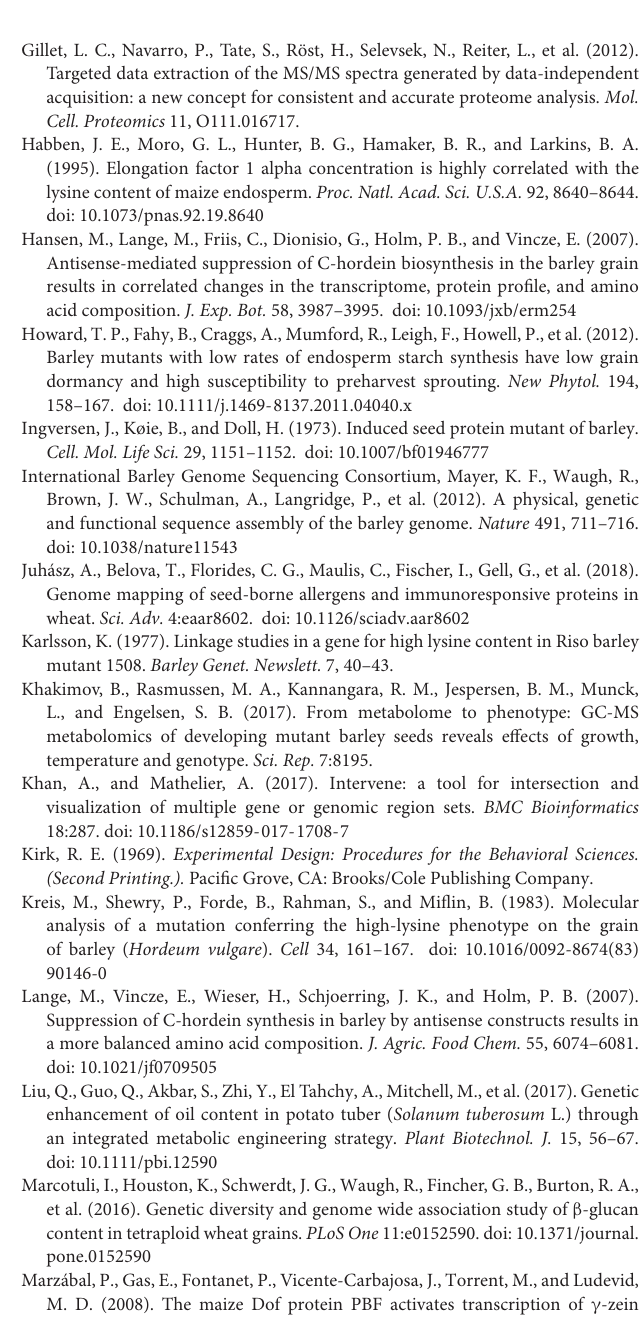
Supplementary Table 1 | Hordein content of WT and hordein-single and DM lines. Supplementary Table 2 | Detailed annotation of mapped protein sequences including their chromosomal position. Supplementary Table 3 | Differentially abundant proteins were functionally annotated and plotted as heatmaps. Supplementary File 1 | Detailed materials and methods for embryo size measurement, barley β -glucan analysis, total starch content analysis, total fatty acid, and total TAG content analysis and circus